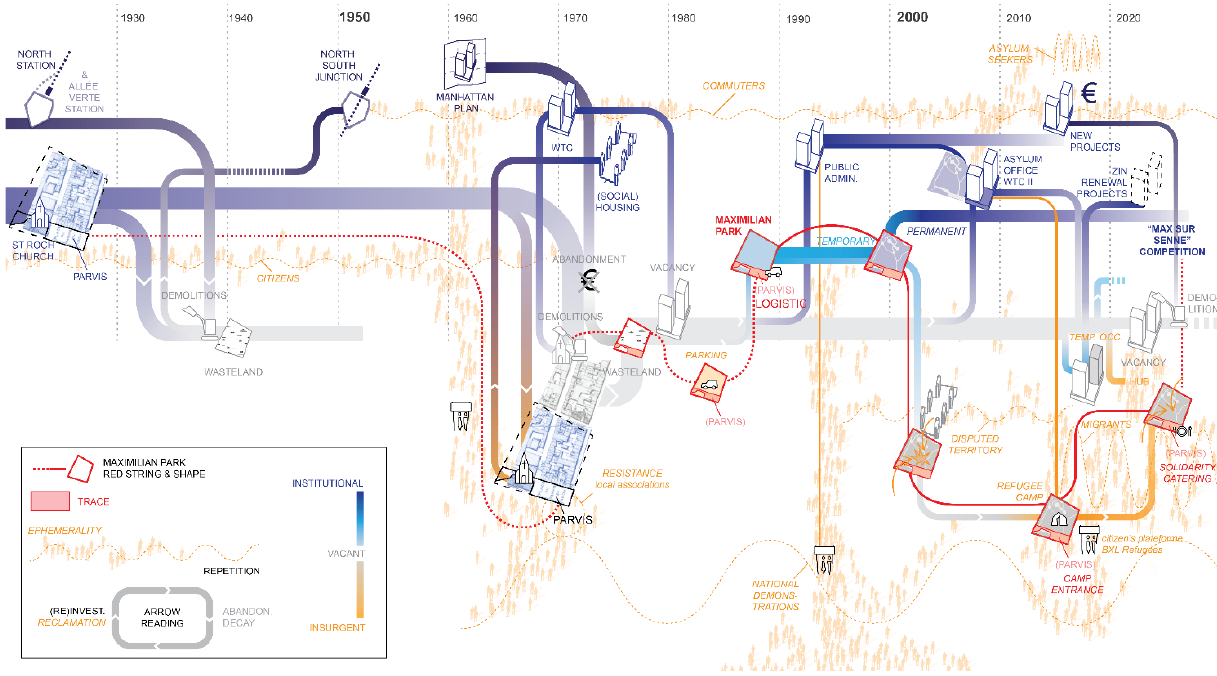
Figure 3. Cycles of decay and reclaim in the North Quarter of Brussels, highlighting Maximilien Park as a trace. Credits